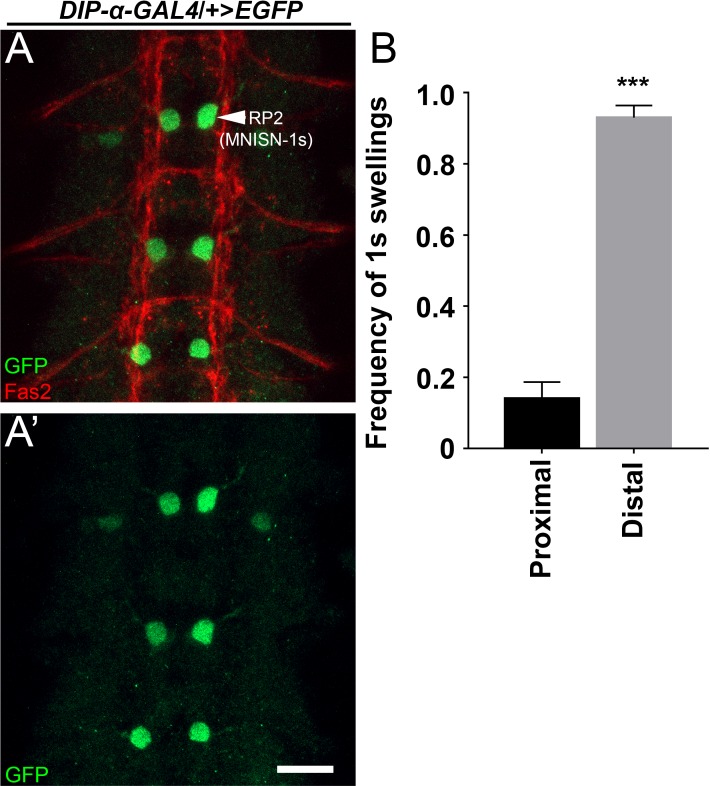
DIP-α is expressed in MNISN-1s motor neurons in st14 embryos, and 1s arbors form over distal muscles before proximal.(A) A ventral nerve cord labeled with anti-GFP (green) and anti-Fas2 (red) from a DIP-α-GAL4 driving EGFP st14 embryo. (B) Frequency of MNISN-1s terminal swellings (varicosity precursors) from DIP-α-T2A-GAL4 driving GFP observed in st16/17 embryos. Terminal swellings are observed predominantly in distal (most dorsal). Calibration bar in A is 14 µm. n (animals/hemisegments) = (6/57). Error bars represent SEM. ***p<0.0001. See also Figure 3.